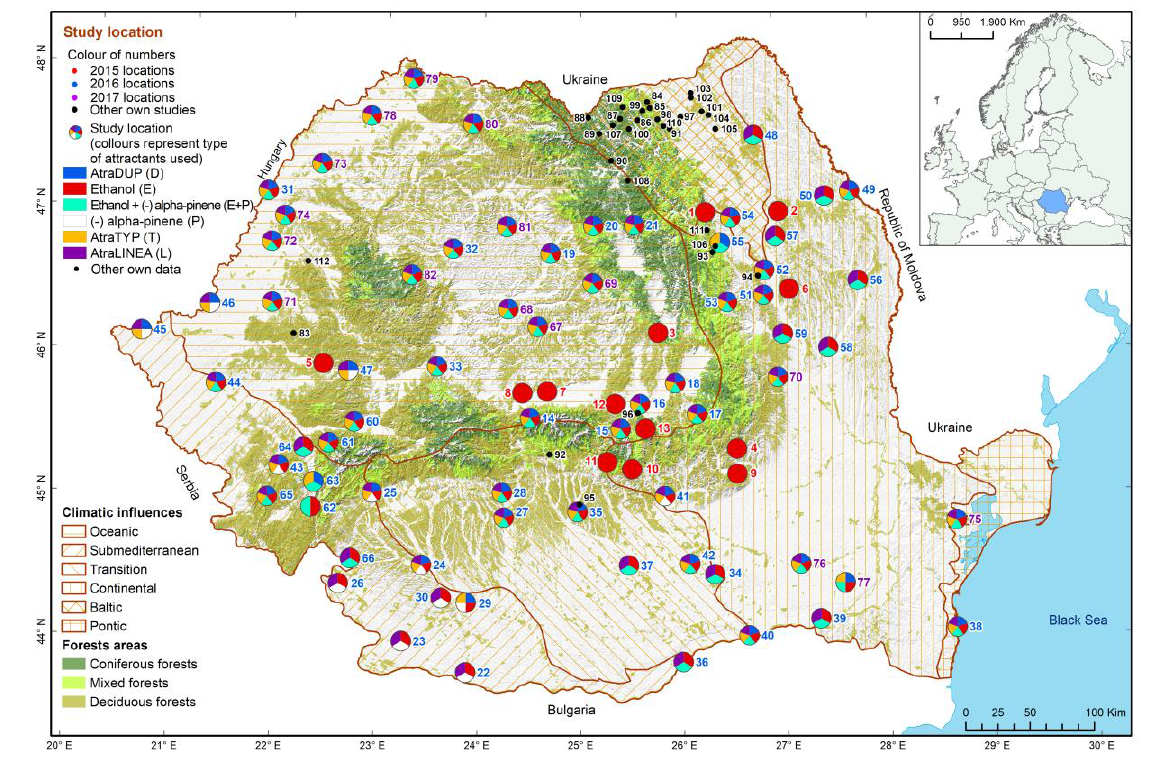
Figure 1. Location of study sites in the survey conducted during 2015–2017, as well as those of our other studies that allowed the collection of NBB and BSB specimens. (The correspondences between point numbers and names of locations are given in Table